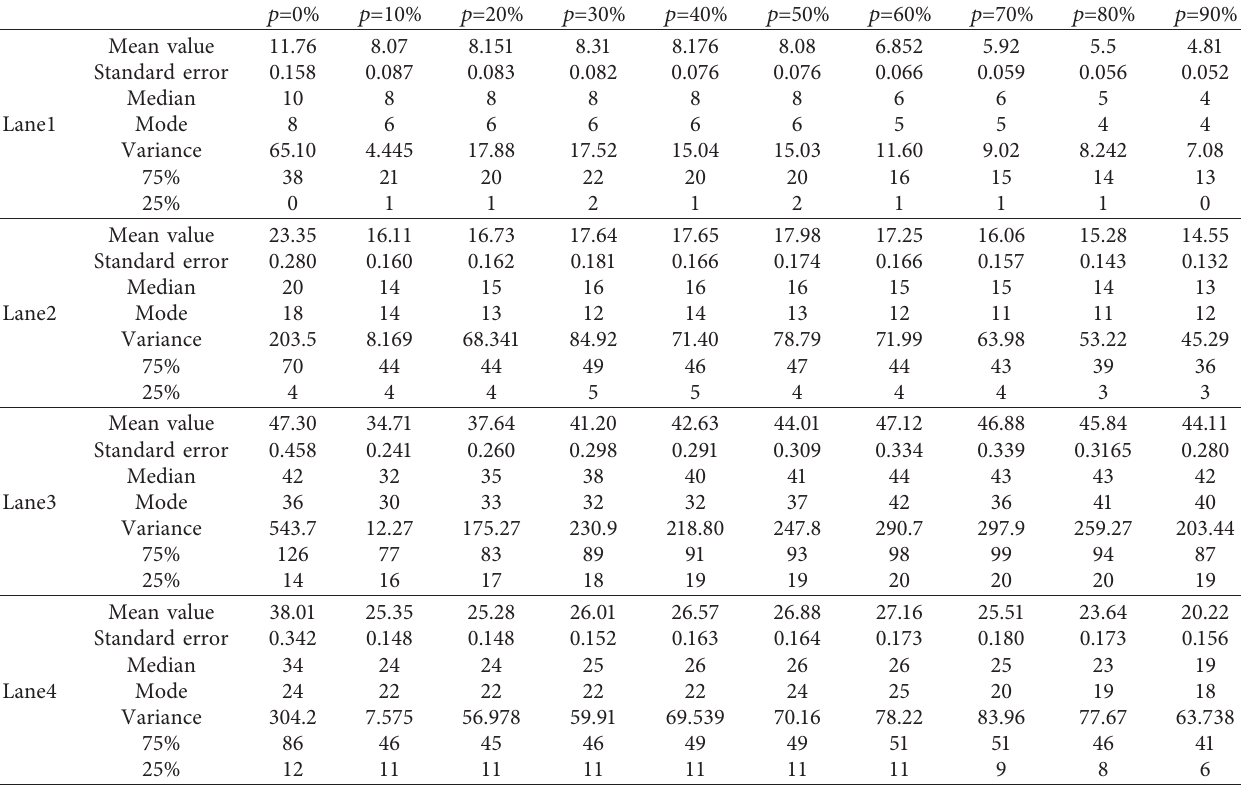
Table 3: The statistical description table of the rate of changing out of lanes of each lane under different autonomous vehicle penetration rates.